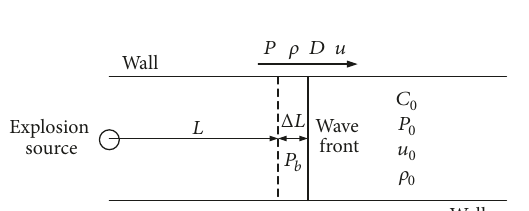
Figure 1: Schematic illustration of the plane shock wave propaga-